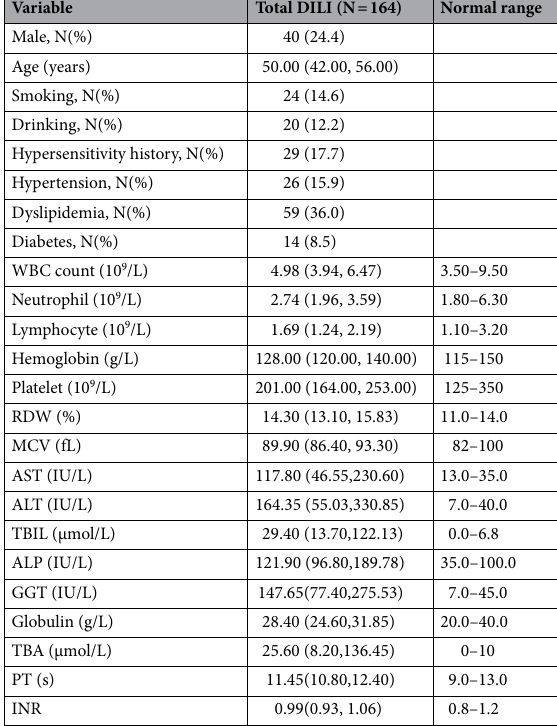
Table 1. Baseline characteristics of the study population. Continuous variables are expressed as median (25th, 75th percentiles) values. Categorical variables were displayed as numbers and percentages. WBC white blood cell, RDW red blood cell distribution width, MCV mean corpuscular volume, AST aspartate aminotransferase, ALT alanine aminotransferase, TBIL total bilirubin, ALP alkaline phosphatase, GGT